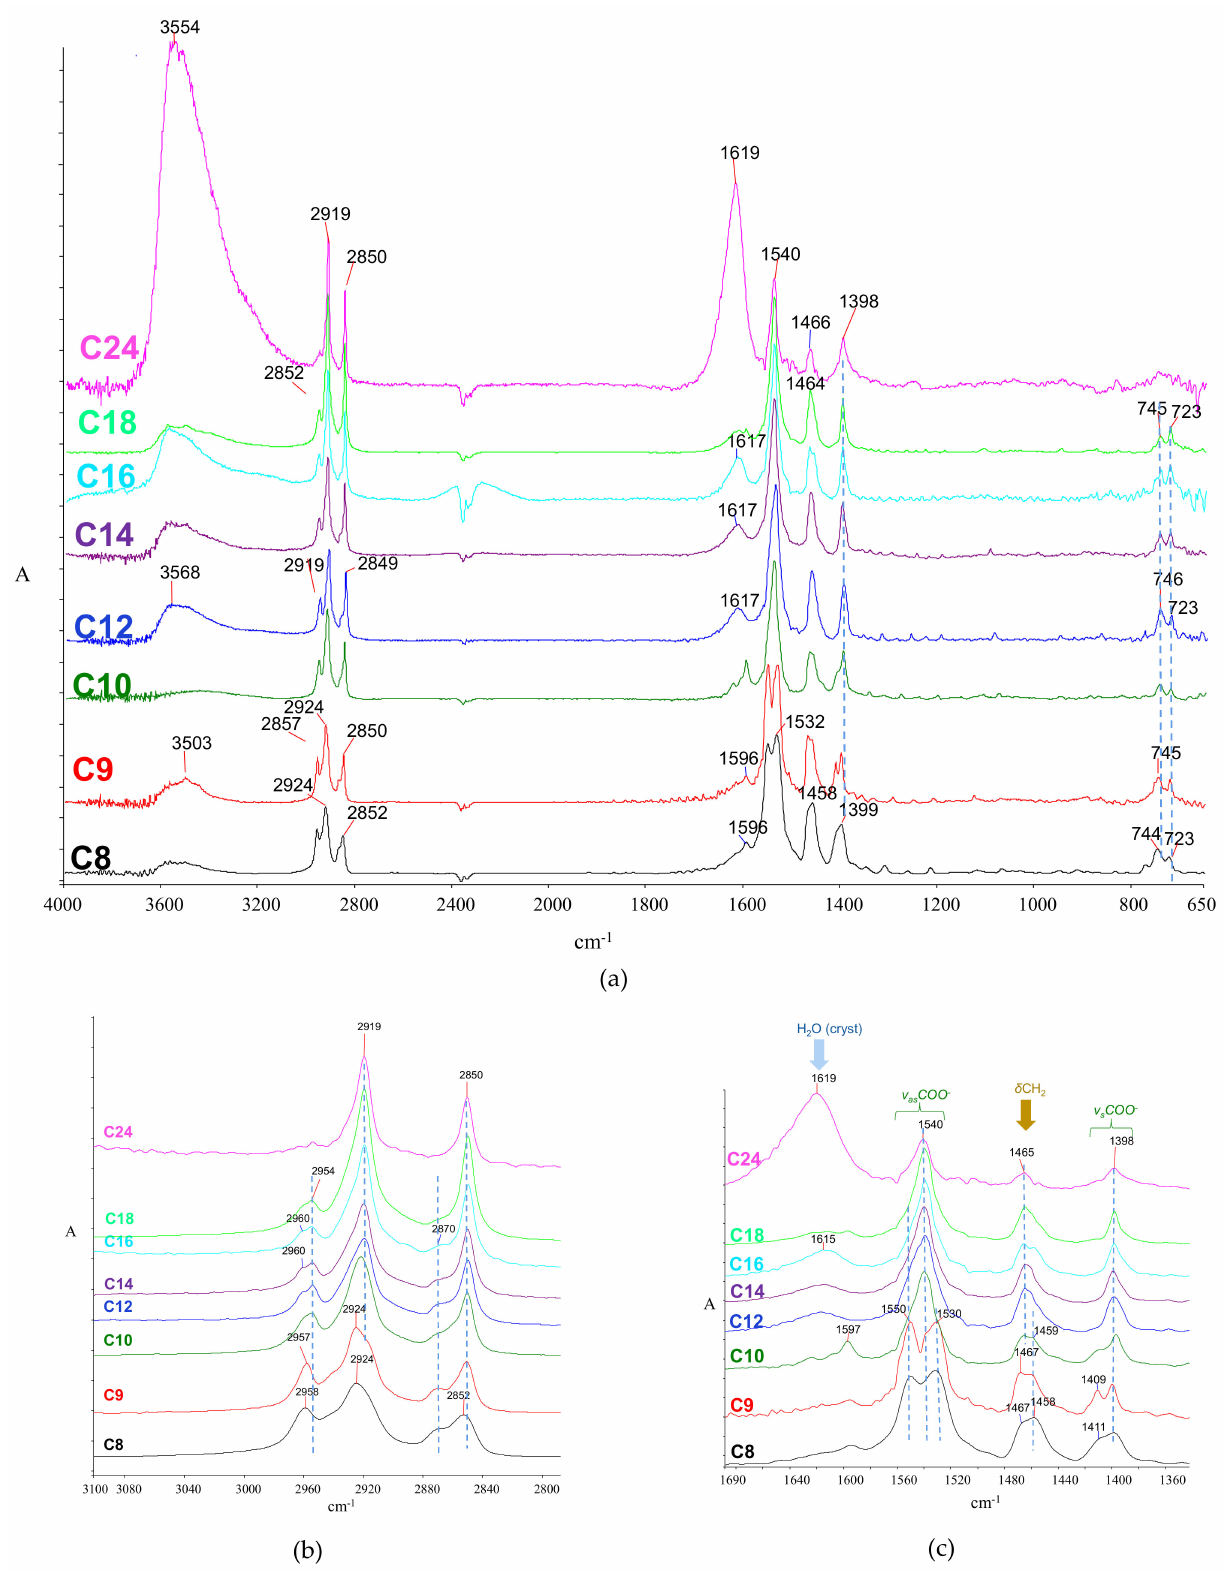
Figure 7. Infrared spectra of fatty acid zinc salts. ( a ) Full spectrum; ( b ) C-H stretching region; and ( c ) carboxylate region. In all spectra: C8, zinc octanoate; C9 zinc nonanoate; C10, zinc decanoate; C12, zinc dodecanoate; C14, zinc tetradecanoate; C16, zinc hexadecanoate; C18, zinc octadecanoate; C24, zinc tetracosanoate. The negative peaks at ~2380 cm − 1 correspond to carbon dioxide as a result of improper background